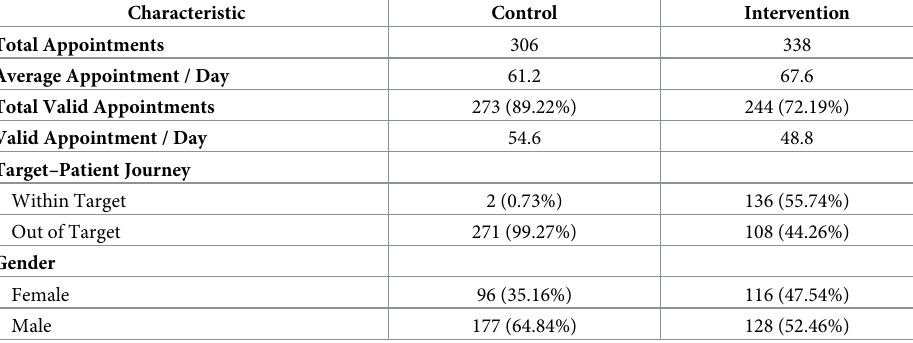
Table 5. Appointment